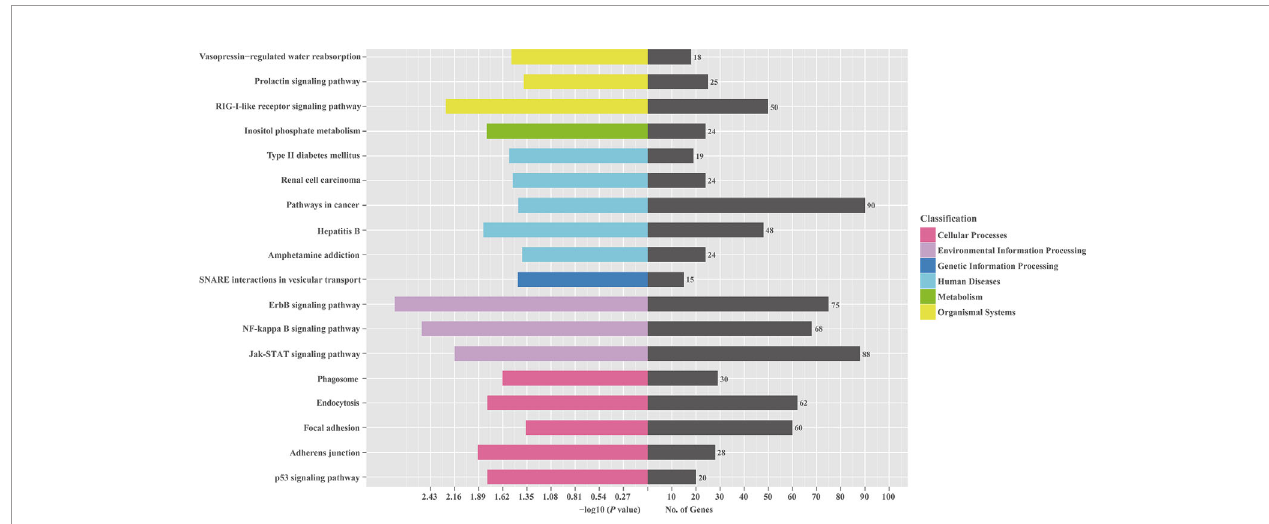
FIGURE 5 | KEGG pathway analysis for the predicted target genes of 23 common SDE miRNAs. The predicted target genes of 23 common SDE miRNAs were chosen for KEGG pathway analysis using the R package named Cluster Pro fi ler based on hyper-geometric distribution. The P -value was calculated through Fisher Exact Test and corrected by FDR. The corrected P -value<0.05 was considered as signi fi cant enrichment.